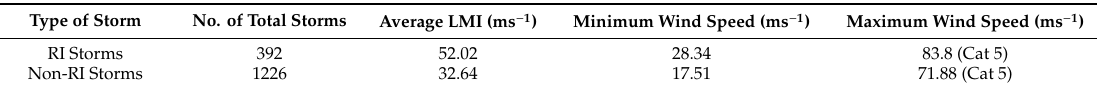
Table 2. Comparison of the number, average lifetime maximum intensity (LMI), minimum wind speed, and maximum windspeed of RI hurricanes and non-RI hurricanes. Category refers to the Sa ffi r-Simpson scale.